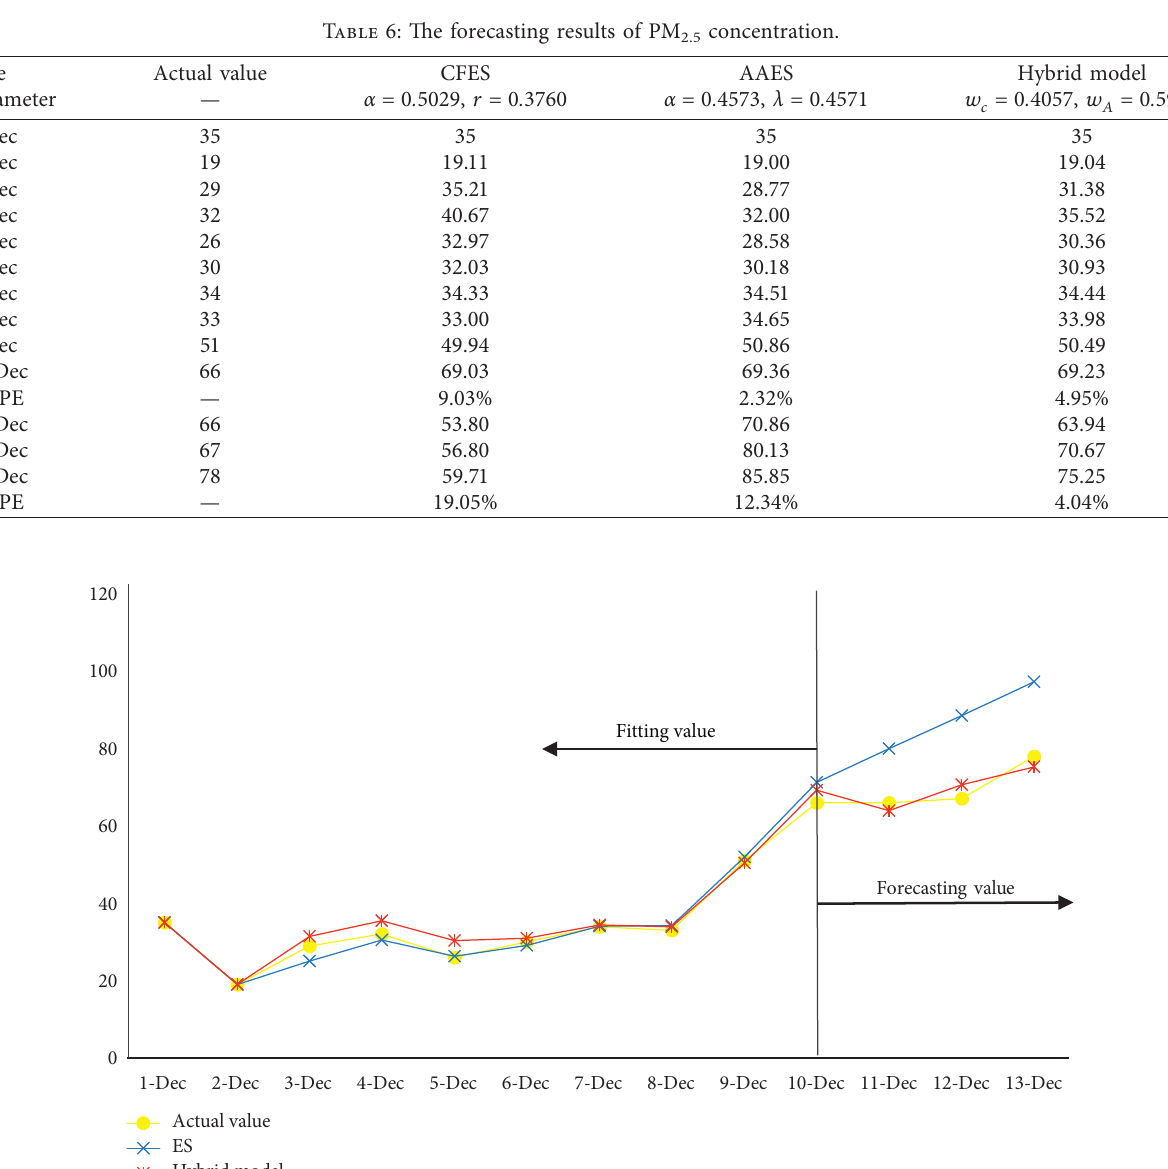
Figure 4: Compared forecasting results between hybrid model and ES in PM